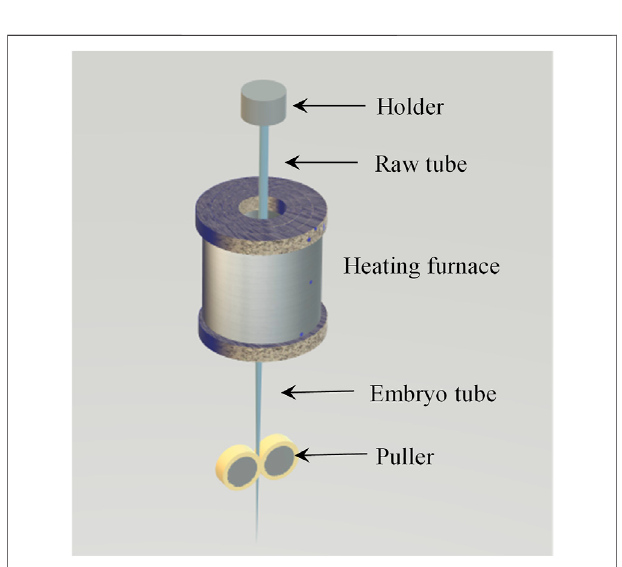
FIGURE 2 | Schematic diagram of the MXRL drawing using an optical fi ber drawing